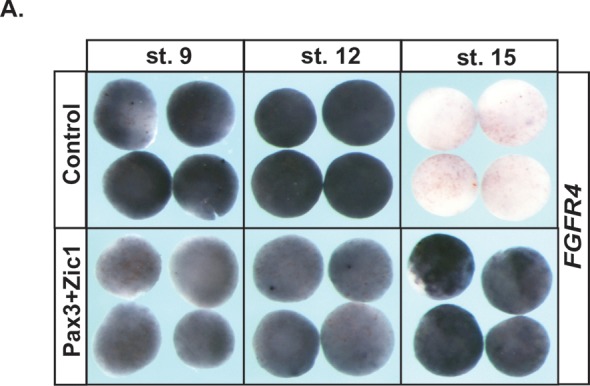
Reprograming to a Neural Crest state sustains FGFR4 expression.(A) Animal pole explant assay examining FGFR4 expression in animal cap explants injected with Pax3-GR/Zic1-GR. Explants were cultured alongside sibling embryos and collected at blastula (stage 9), midgastrula (stage 12), and midneurula (stage 15) stages. Reprogramming to a neural crest state causes sustained FGFR4 expression.